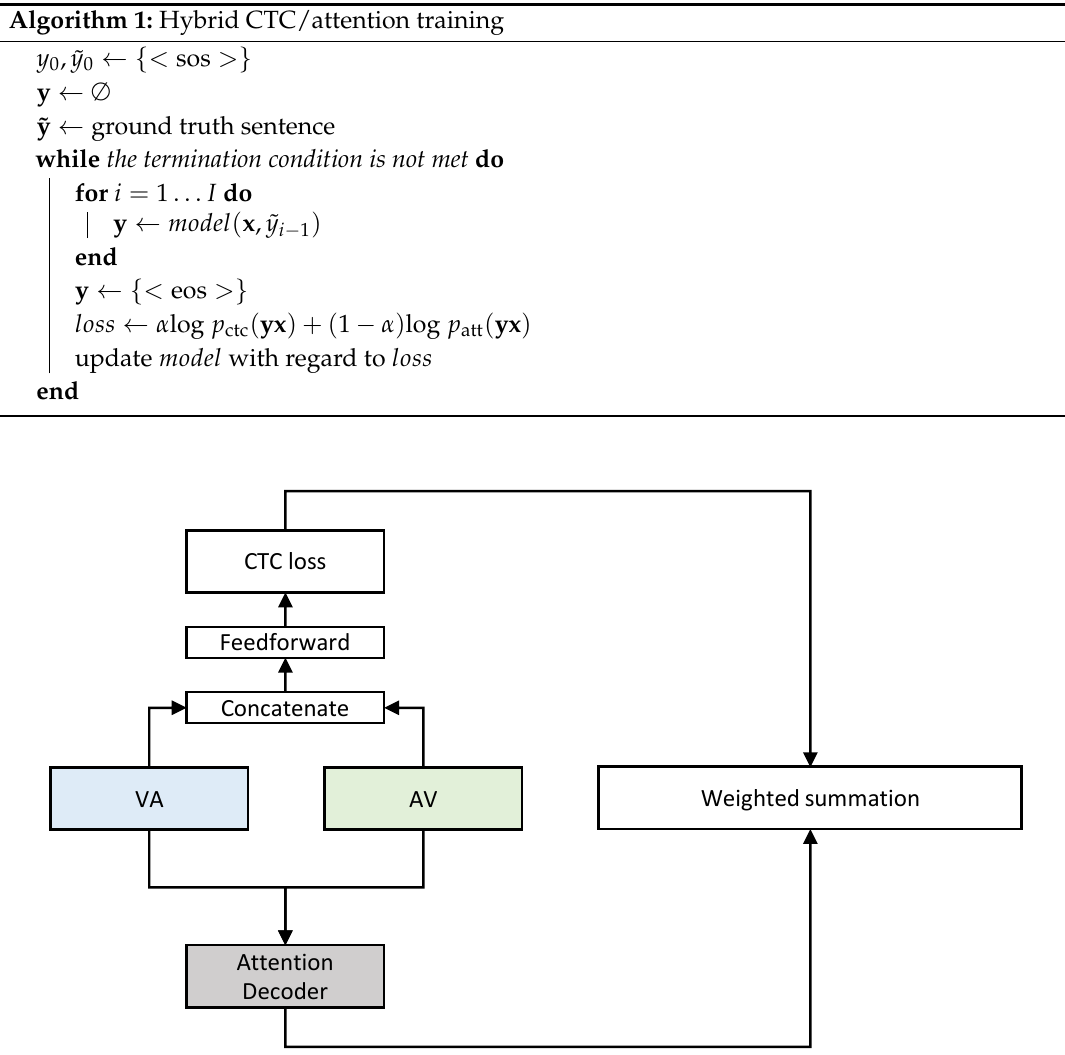
Figure 5. Procedure to compute the loss function for the TM-DCM model. The TM-DCM model is trained by using the hybrid CTC/attention architecture to force monotonic alignments required for speech